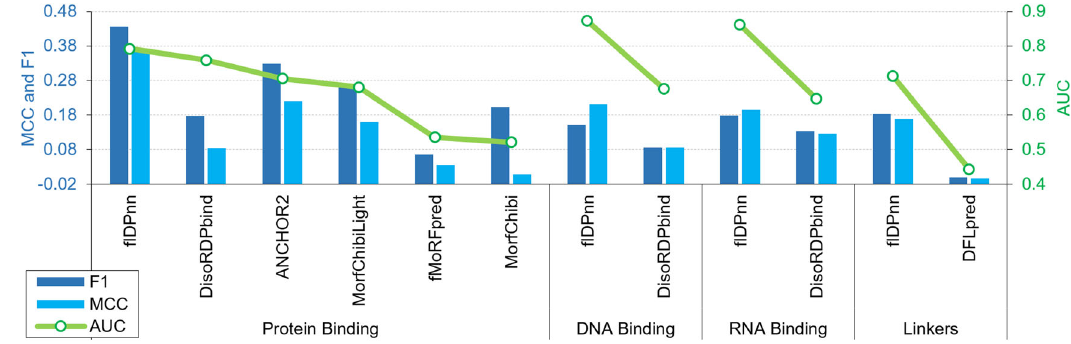
Fig. 4 Assessment of the quality of the disorder function predictions for the IDRs predicted by fl DPnn on the test dataset. AUC (area under the ROC curve); MCC (Matthews correlation coef fi cient). The predictive quality for the putative function propensities and binary predictions is quanti fi ed with AUC (green lines) and with MCC and F1 scores (blue